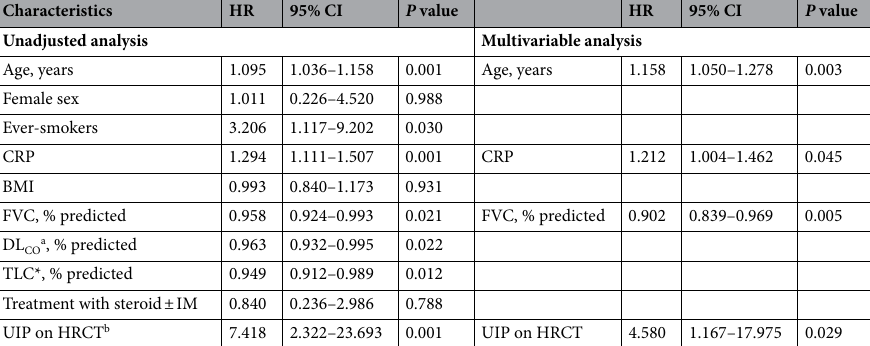
Table 4. Prognostic factors for mortality in patients with SJS-ILD assessed using a Cox proportional hazards model. BMI body mass index, CI confidence interval, CRP C-reactive protein, DL CO diffusing capacity of the lung for carbon monoxide, FVC forced vital capacity, HR hazard ratio, HRCT high-resolution computed tomography, ILD interstitial lung disease, IM immunosuppressants, SJS Sjögren syndrome, TLC total lung capacity, UIP usual interstitial pneumonia. a Baseline DL CO and TLC were not included in the multivariable analysis due to their close correlation with FVC (vs. DL CO , correlation coefficient = 0.710, P < 0.001; vs. TLC, correlation coefficient = 0.873, P < 0.001). b UIP to non-UIP.